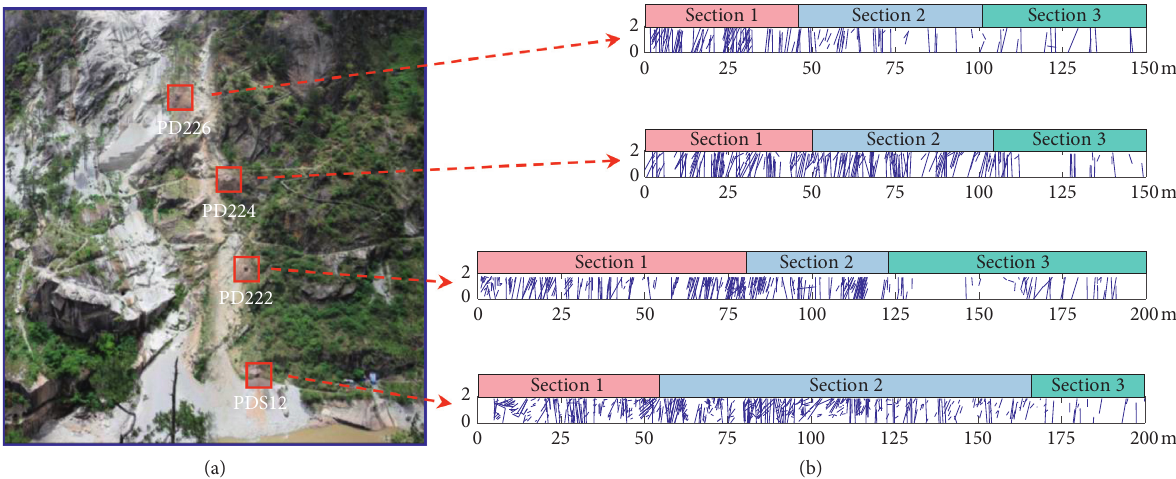
Figure 5: The distribution map of the adits (a) and the sectional map of the rock mass around the adits